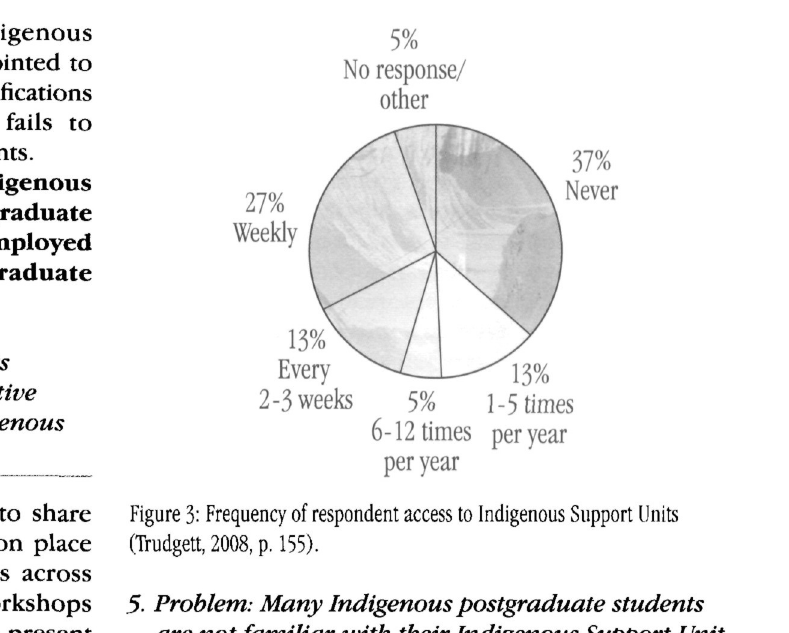
Figure 3: Frequency of respondent access to Indigenous Support Units (Trudgett, 2008, p.